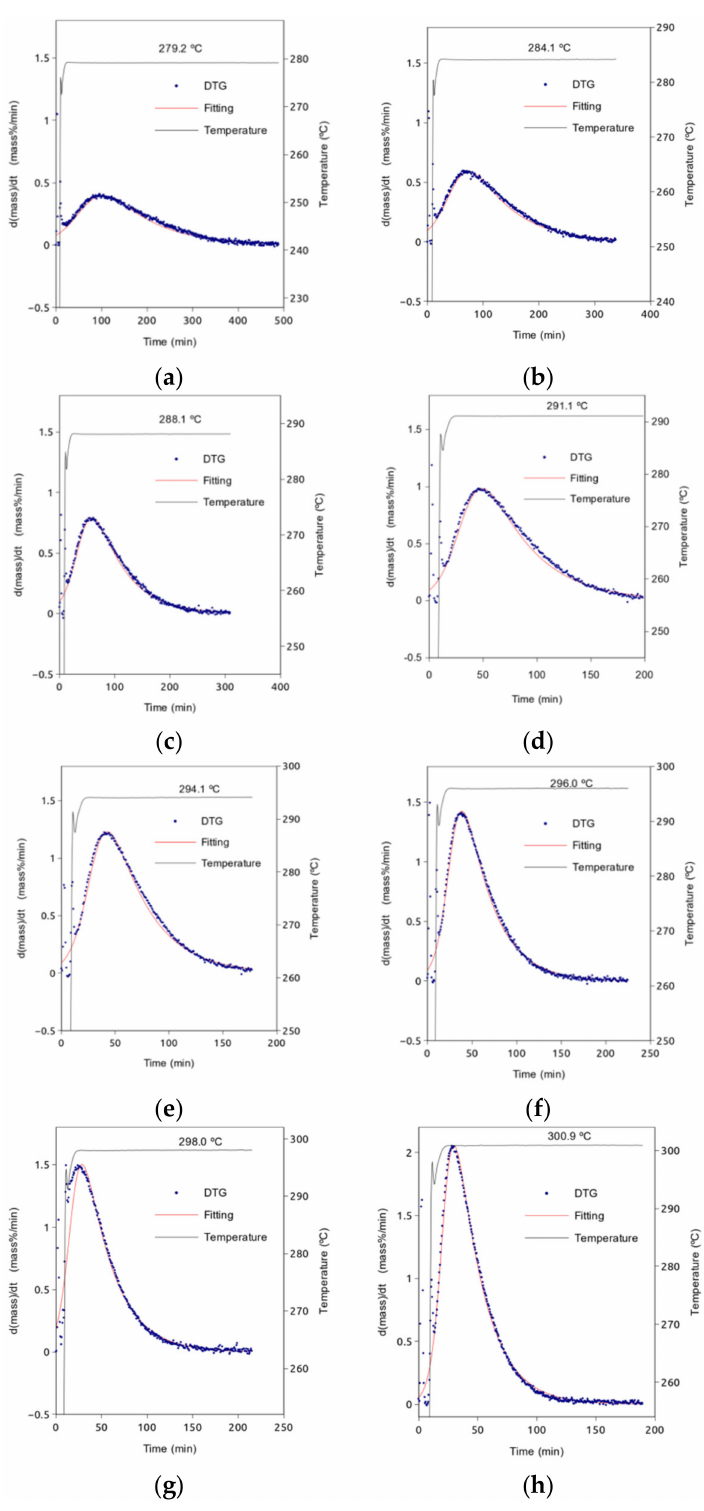
Figure A1. Plots of all DTG curves with their corresponding fittings at the indicated temperatures: 279.2